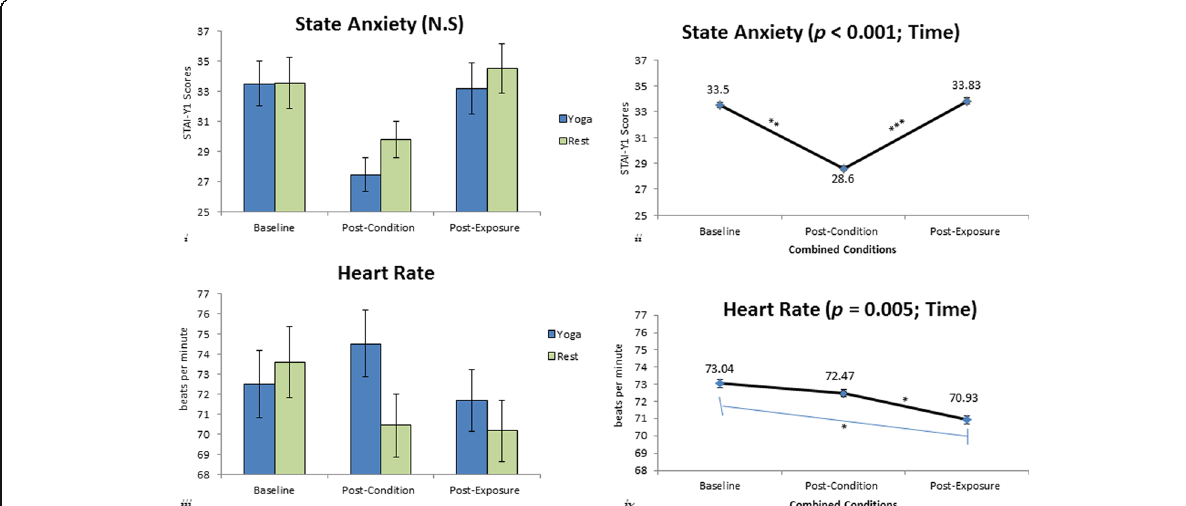
Fig. 2 (i) State anxiety scores at baseline, post-condition, and post-exposure for the yoga and rest conditions. No significant difference between the yoga and rest conditions. (ii) Combined state anxiety scores at baseline, post-condition and post-exposure. Significant decrease , **p = 0.001, between baseline and post-condition and significant increase , ***p< 0 .001, between post-condition and post-exposure. (iii) Heart rate (HR) at baseline, post-condition and post-exposure for the yoga and rest conditions. Significant interaction between condition & time, ***p < 0 .001. (iv) Combined HR for both conditions at baseline, post-condition and post-exposure. Significant decrease between post-condition and post-exposure, * p = 0 . 020 and between baseline and post-exposure, * p = 0 .033. Note symbols or abbreviations on graphs: N.S.- not significant , *p < 0.05, **p = 0 .001 , and ***p < 0 .001. Error bars = SEM